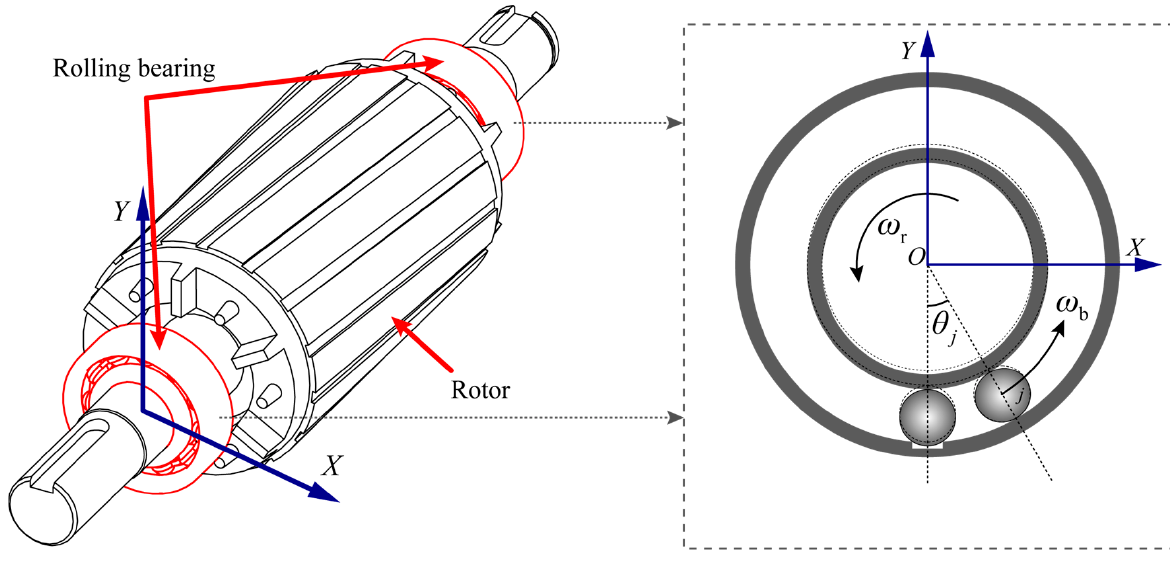
Figure 9. Rotor-bearing system dynamic model.